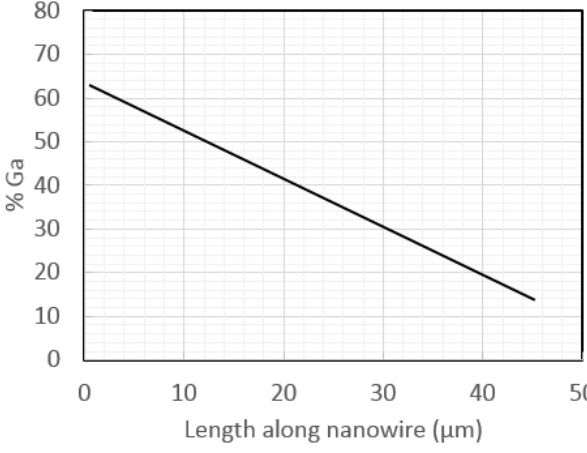
Figure 8. Initial trend of compostion change along nanowire lengths, later mitigated using [Cit] complexing [9].